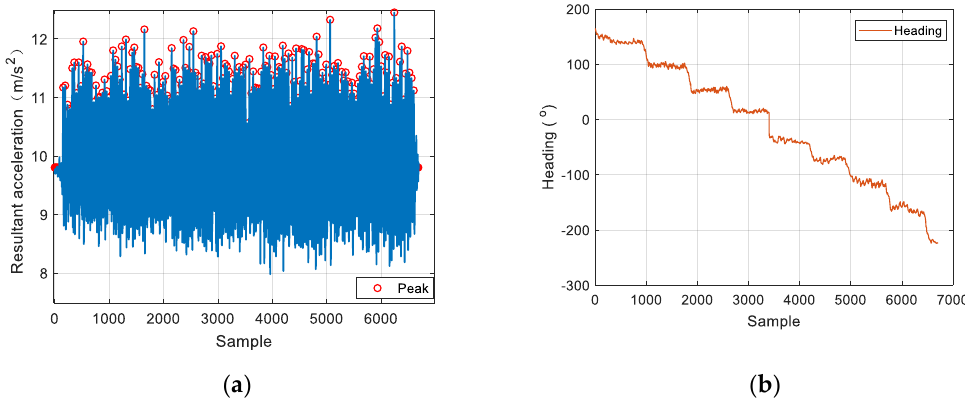
Figure 13. The PDR information in the fountain experiment environment. ( a ) The results of gait detection, based on the IFSM algorithm; ( b ) the estimations of the heading angle.